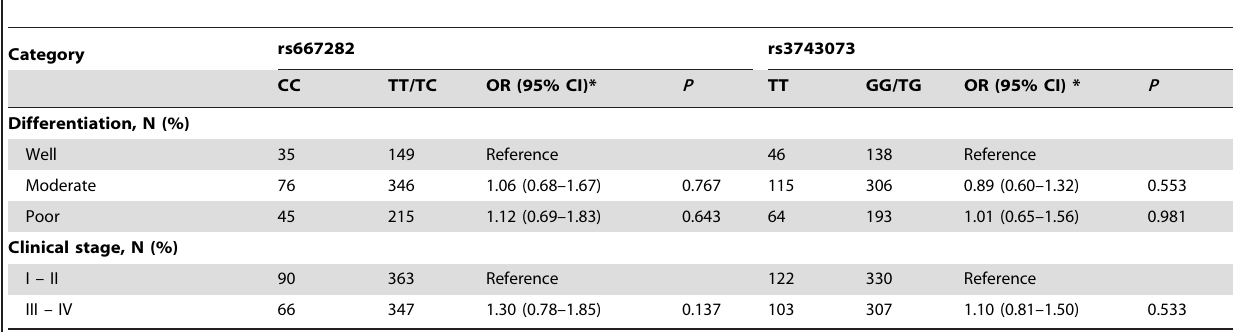
Table 4. Association between 2 SNPs genotype groups with histological grade and clinical stage of ESCC.